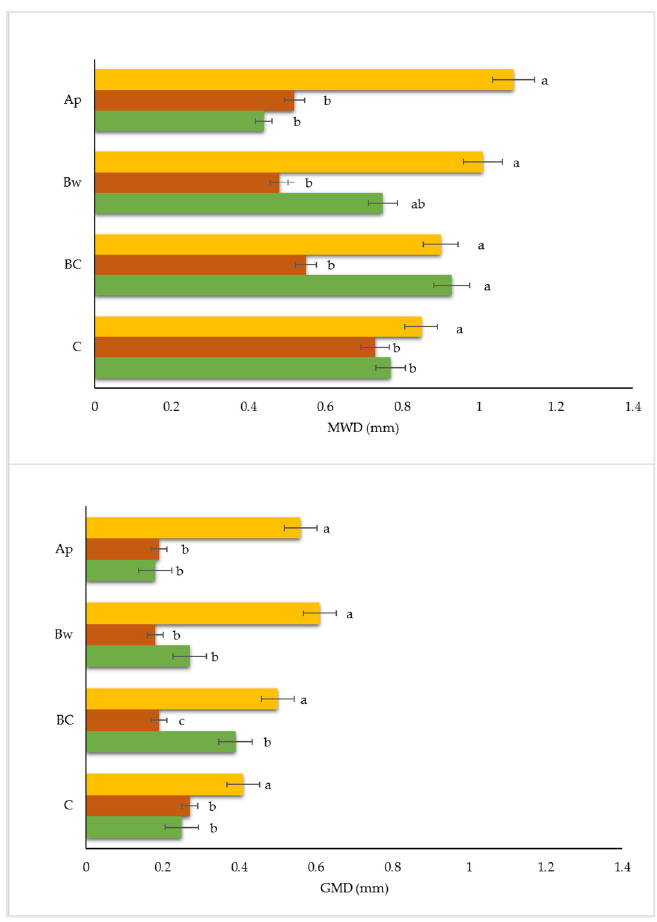
Figure 3. Mean weight diameter (MWD) and geometric mean diameter (GMD) of soil aggregates for initial situation (CT0; yellow bars), conventional-tillage (CT1; red bars) and no-till (NT+H; green bars) treatments at different horizons. Values are given as mean ± standard error (n = 5). The different lowercase letters above the error bars for the same soil horizon indicate significant differences based on post-hoc tests, Tukey’s honestly significant difference (HSD) between management at p < 0.05.